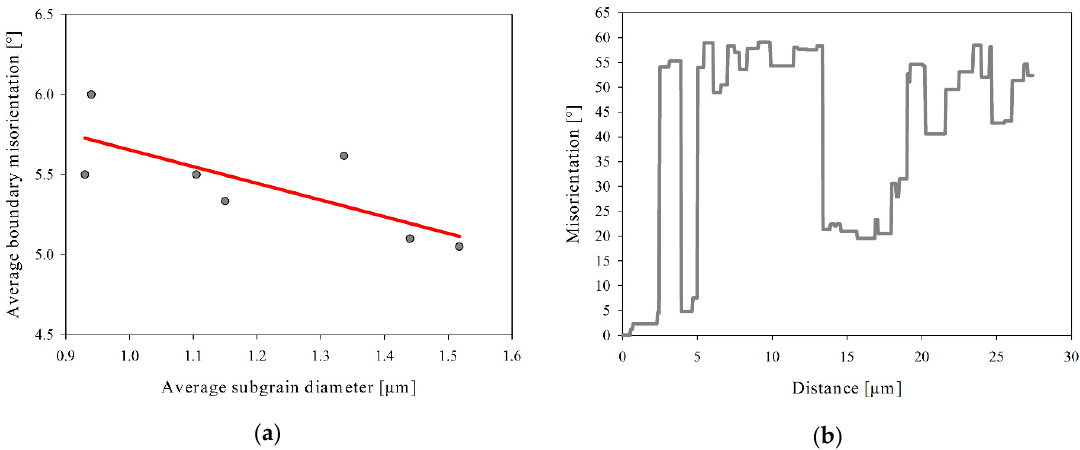
Figure 10. ( a ) Average boundary misorientation versus average subgrain size in CP Al when subgrain growth is followed independently of orientation. ( b ) Misorientation profile for CP Al samples after 10 5 s of annealing at 250 °C.